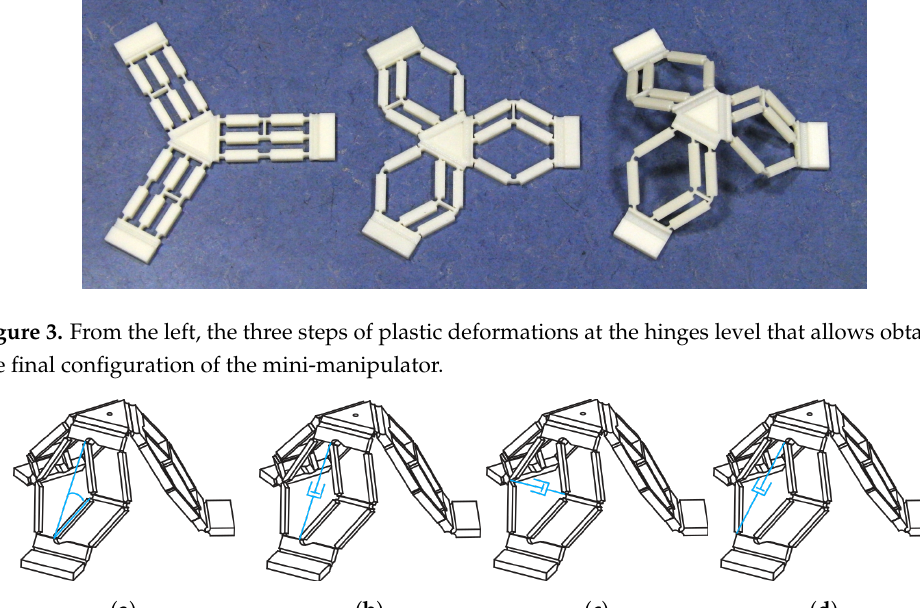
Figure 4. From the left, four alternative actuation strategies: ( a ) a rotative actuation, and a linear actuation between ( b ) radially aligned joints, ( c ) horizontally aligned joints, and ( d ) not aligned joints.